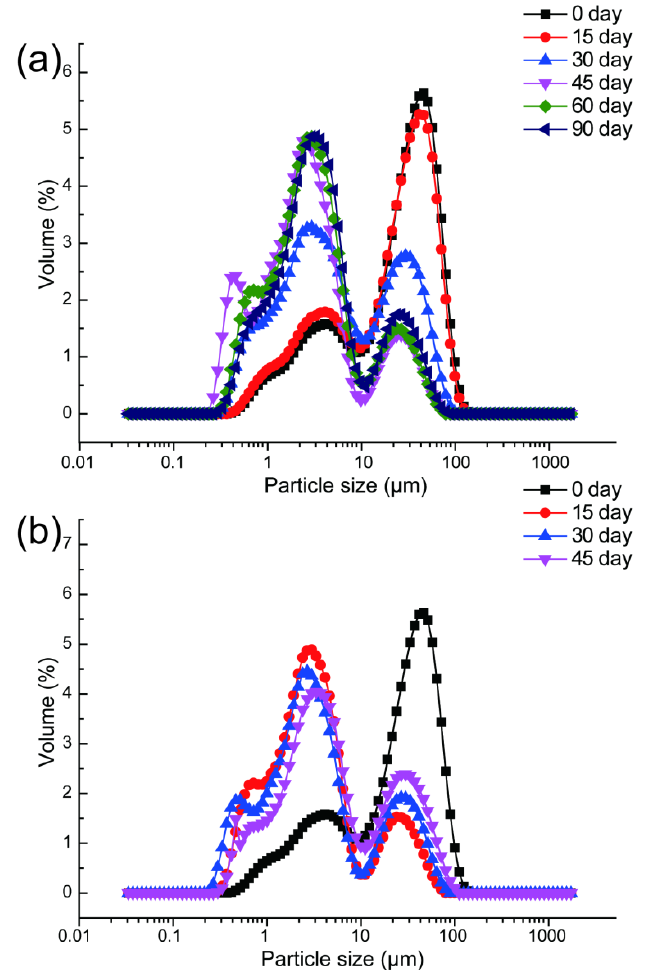
Figure 4. Particle size distribution (PSD) of NFC apple juice from fruit under different temperatures and times. 0 °C ( a ), 20 °C ( b ). ( n = 3). Table 2. D (4,3), D (3,2), and D50 of cloudy apple juice (mean ± S.D.) from fruit storage